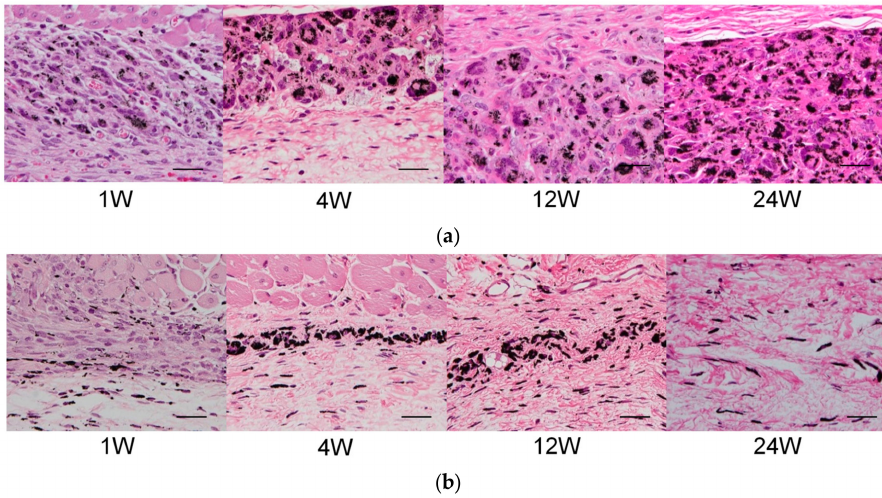
Figure 2. A histopathological image of the skin of ddY mice, subcutaneously administered with MWCNTs. ( a ) Group administered with MWCNT; ( b ) group administered with tattoo ink. In both groups, carbon particles are observed in the macrophages at one week following administration with slight inflammatory cell infiltration around them. At four weeks, carbon particles have remained in the macrophages, and the inflammatory reaction has subsided. Scale bar, 20 µ m. Reproduced with permission from [16]. Elsevier,